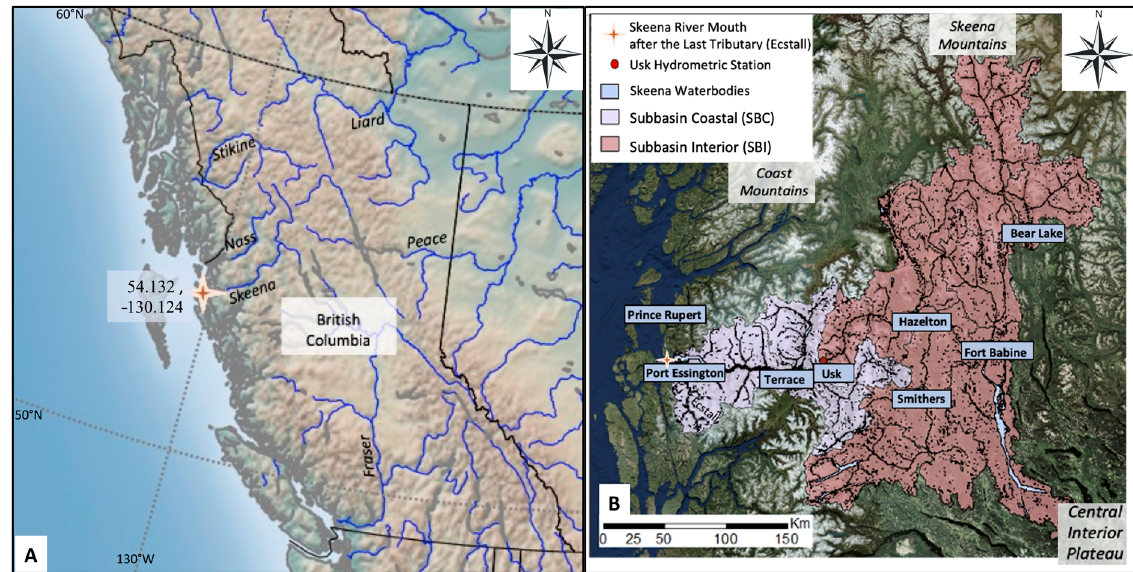
Figure 1. ( A ) The Skeena River in northwestern British Columbia, Canada. ( B ) Interior areas upstream (SBI) and coastal catchment areas downstream (SBC) of Usk hydrometric station. Notice the northwest-trending Coast and Skeena Mountain chains along with the glaciated areas of the basin (right). Major town names are added for reference.